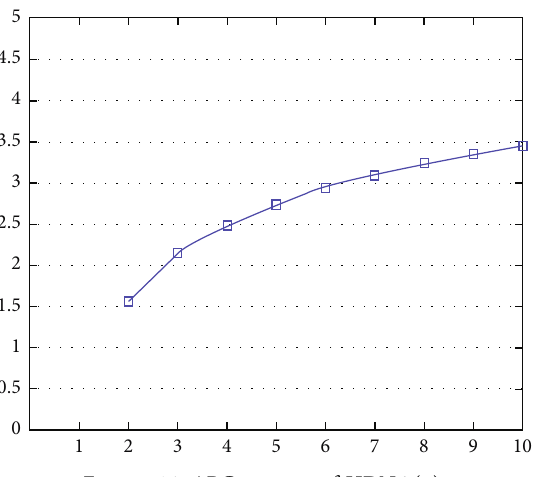
Figure 14: ABC entropy of HDN2 ( n ) .